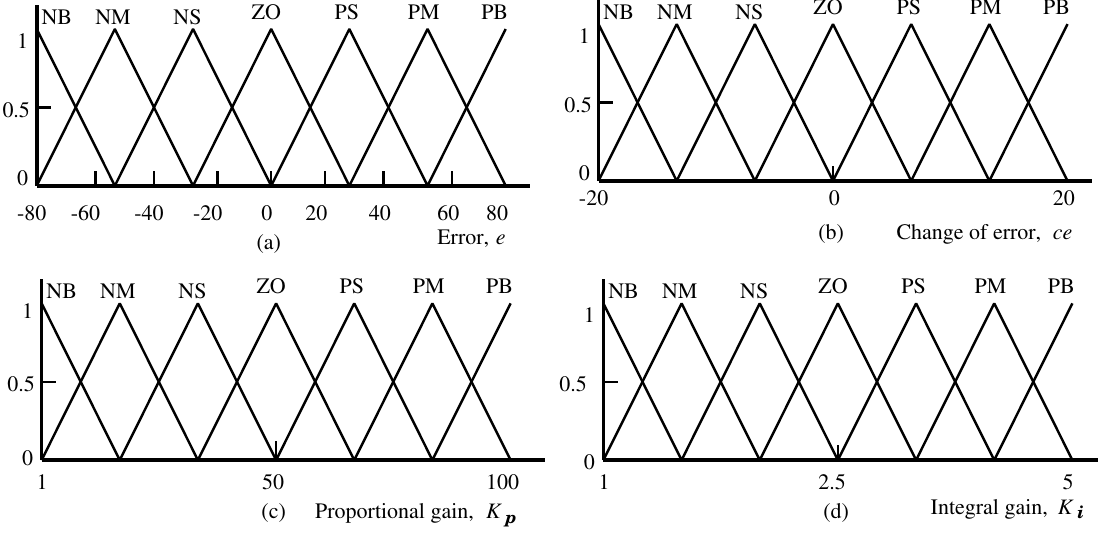
Figure 9. Fuzzy membership functions ( a ) input members; error e ( b ) input members; change of error ce ( c ) output members; proportional gain K gain K i